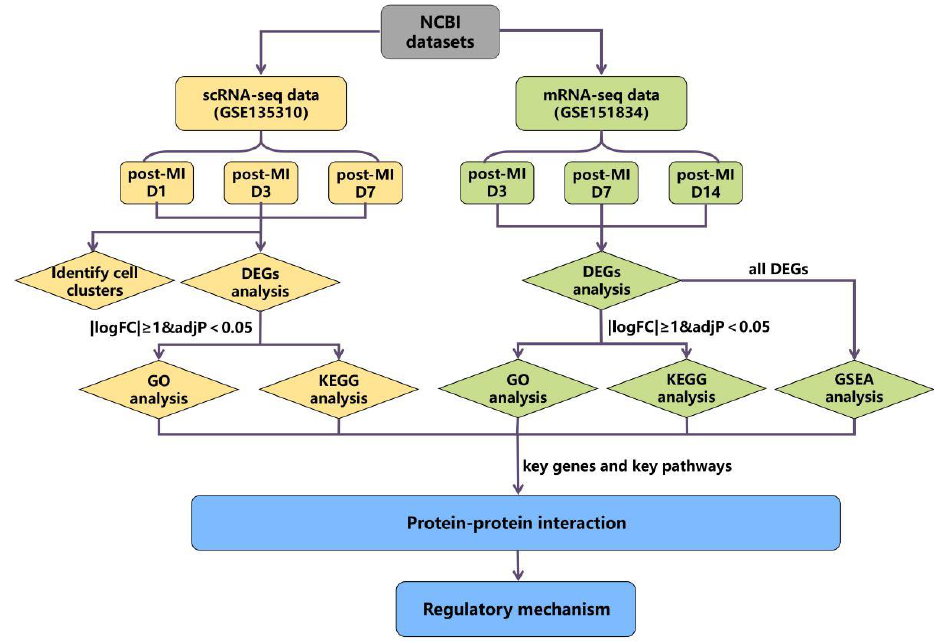
Figure 1. The flow diagram of data analysis.